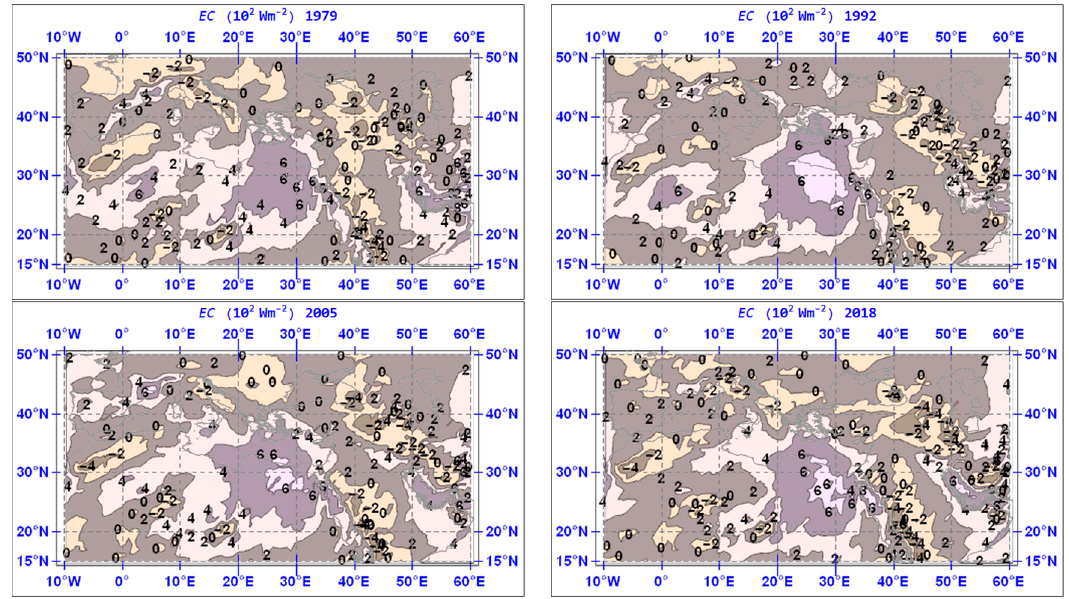
Figure 16. Same as Figure 4, but for EC . Isopleths are drawn for every 2 × 10 2 Wm − 2 .